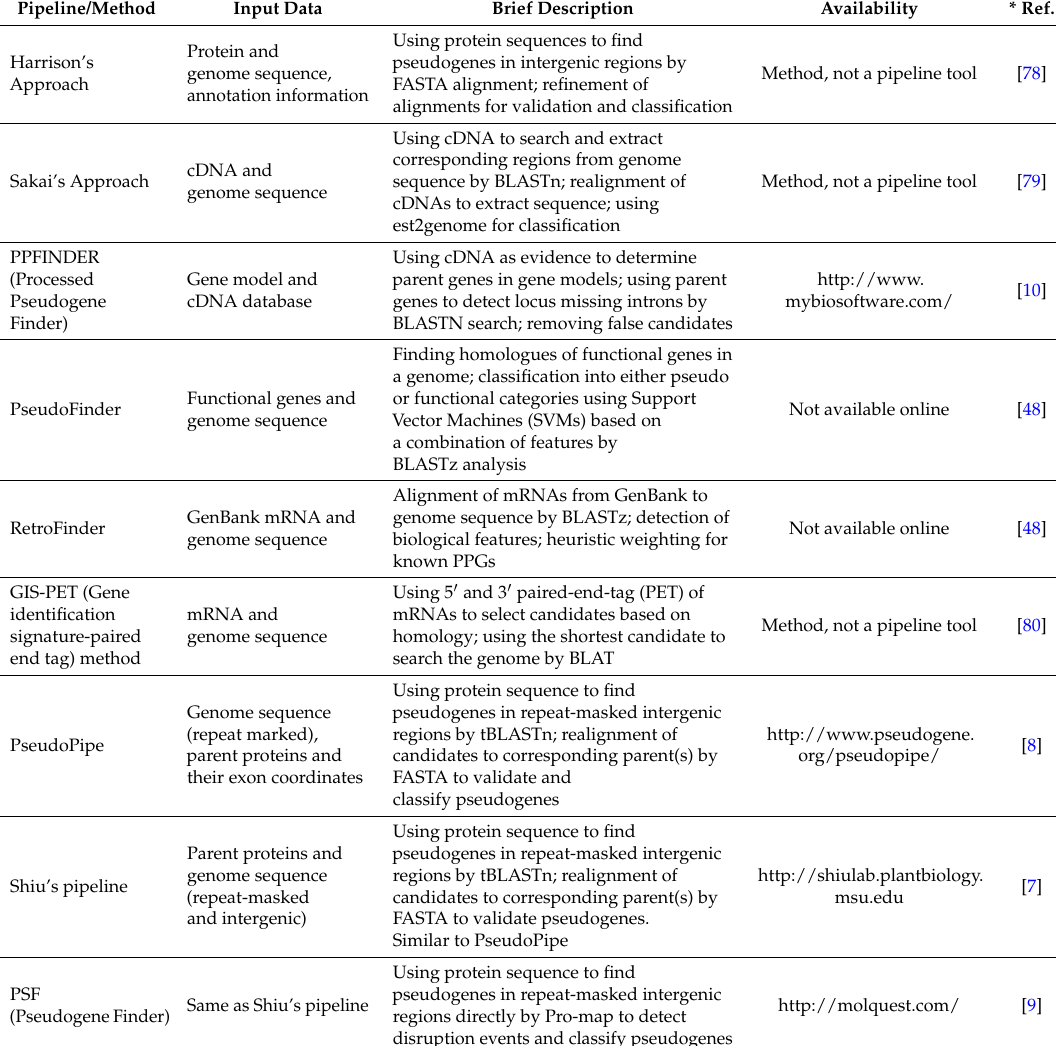
Table 2. Bioinformatics pipelines or approaches for predicting